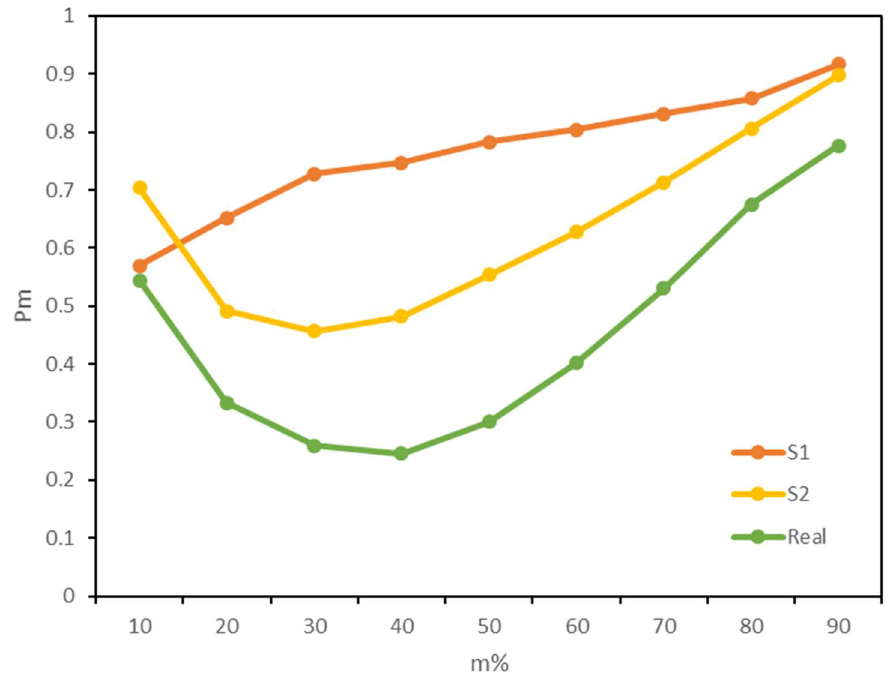
Figure 8. The preservation ratios (Pm) calculated for one read-world dataset (Real) and two synthetic datasets (S1 and S2).